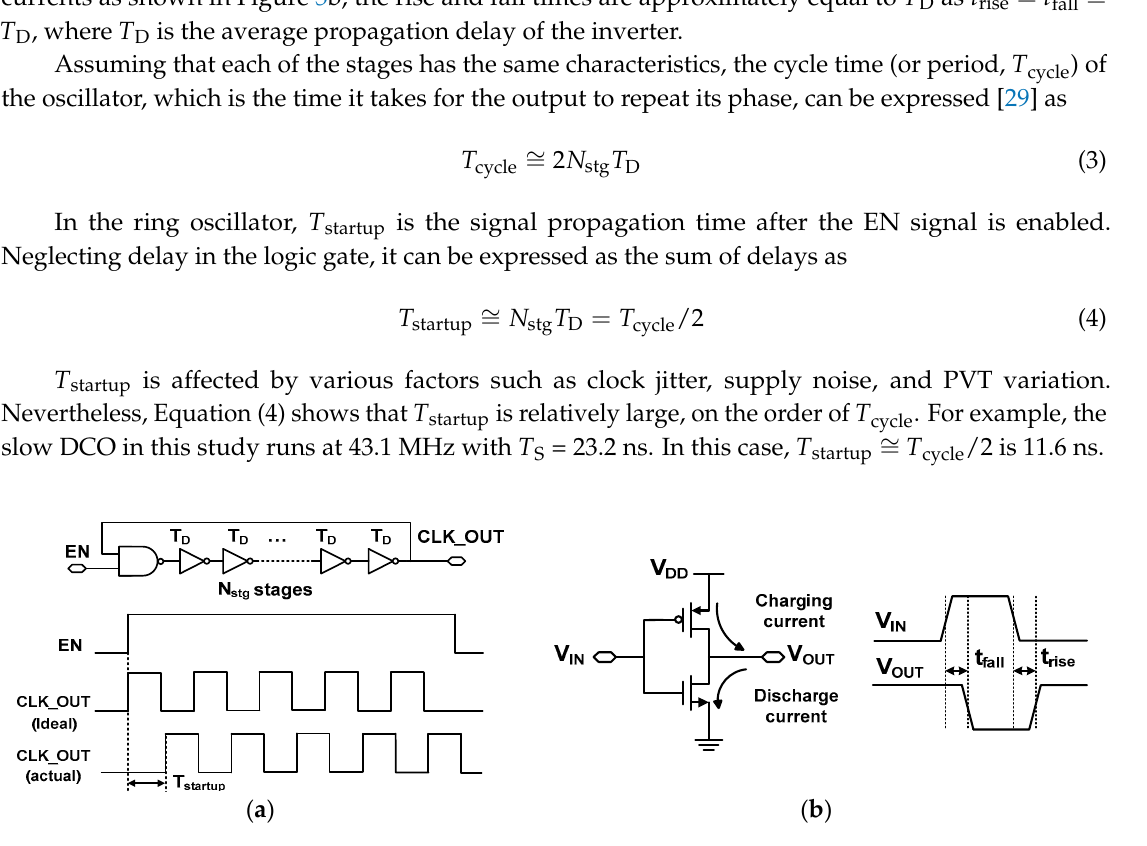
Figure 5. ( a ) Timing waveform of a ring oscillator. ( b ) Charging and discharging currents in an